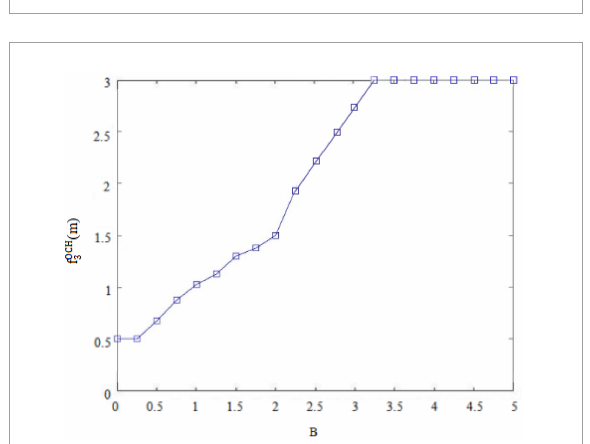
FIGURE7 Deviant innovative behaviors and perceived benefits of “outsiders’ subordinates” with high internal control personality.